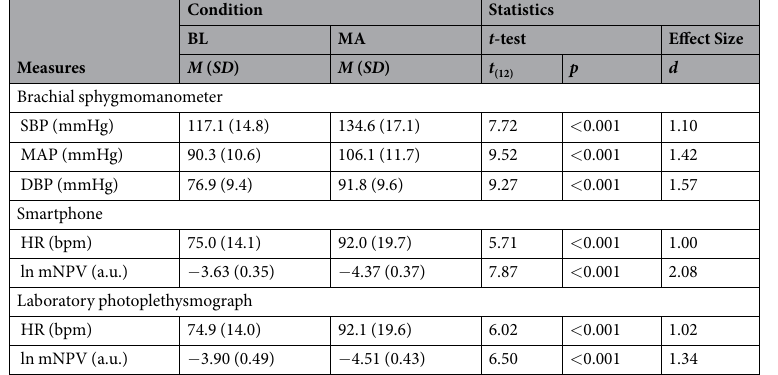
Table 1. Physiological variables during two conditions simultaneously measured by each device. Note . SBP = systolic blood pressure, MAP = mean arterial pressure, DBP = diastolic blood pressure, HR = heart rate, mNPV = modified normalized pulse volume, BL = baseline, MA = mental arithmetic, a.u. = arbitrary